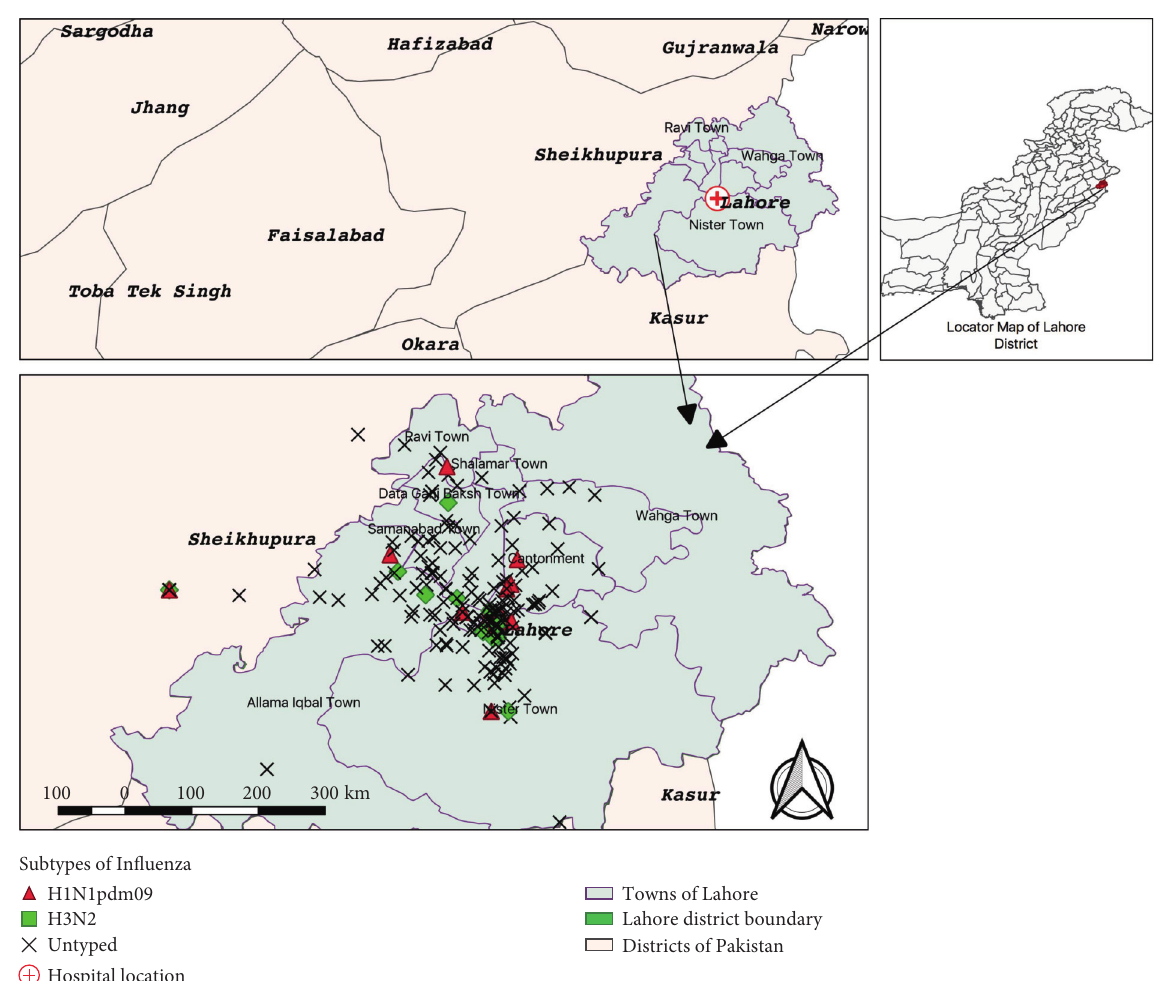
Figure 2: Spatial distribution of influenza A-positive cases with different subtypes from hospital-based sentinel surveillance during Oct 2015–May